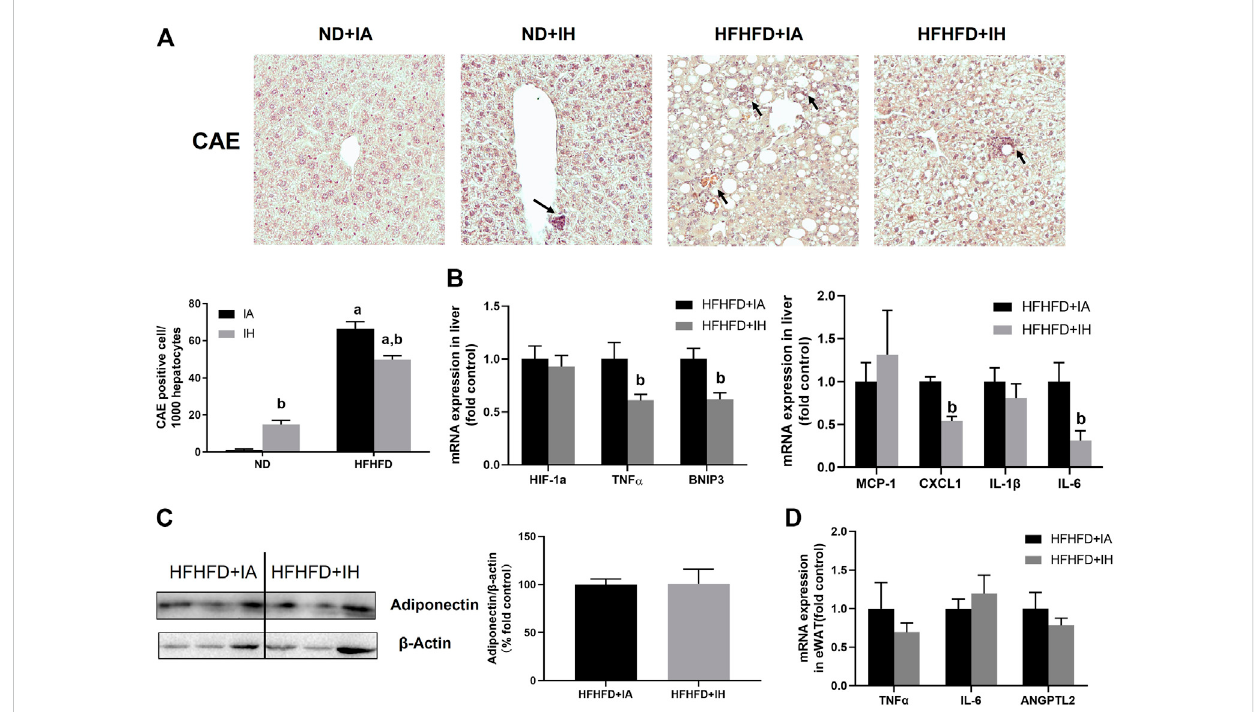
FIGURE 6 IH reduced in fl ammation in HFHFD-fed mice. (A) Representative photomicrographs of CAE (neutrophils, purple) are shown at ×200 magni fi cation. CAE-positive cells were counted and graphed as positive cells per 1,000 hepatocytes. (B) Hepatic expressions of genes related to in fl ammation are shown. (C) Representativewesternblotanalysesanddensitometricanalysisforadiponectininadiposetissueareperformed. (D) mRNAexpressionofpro- in fl ammatory adipokines in HFHFD + IA and HFHFD + IH mice are shown. a, p < 0.05 compared to ND control, b, p < 0.05 compared to absence of IH. Samples size per group n = 4 – 6.